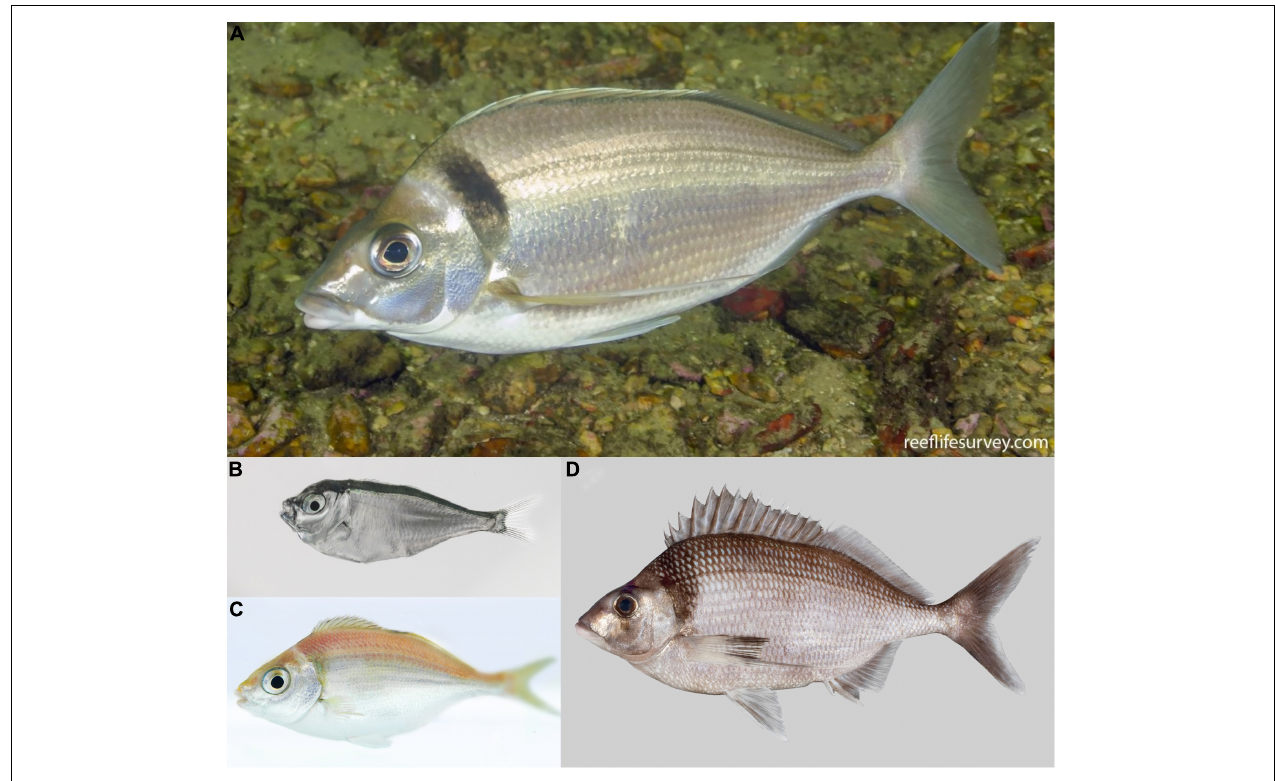
FIGURE 1 | (A) An adult tarakihi ( Nemadactylus macropterus ) in Port Davey, Tasmania. In the late-larval stage (B) , the individuals display a deep body with a strong ventral keel particularly adapted to pelagic life. This “paperfish” stage is thought to be an important stage for dispersal of tarakihi due to its duration (c. 10 months) and the strong influence of oceanic currents on its spatial distribution. Metamorphosis into the juvenile stage (C) occurs when the fish are 7–12 months old and 7–9 cm long. At this stage, the individuals settle in “nurseries” and become more sedentary. (D) King tarakihi ( Nemadactylus n.sp); the main visually recognizable difference to tarakihi is the presence of a black band on the pectoral fin. Pictures by courtesy of (A) Ian Shaw, Reef Life Survey, (B,C) Robert Lamberts, the New Zealand Institute for Plant and Food Research Limited, and (D) the Museum of New Zealand Te Papa